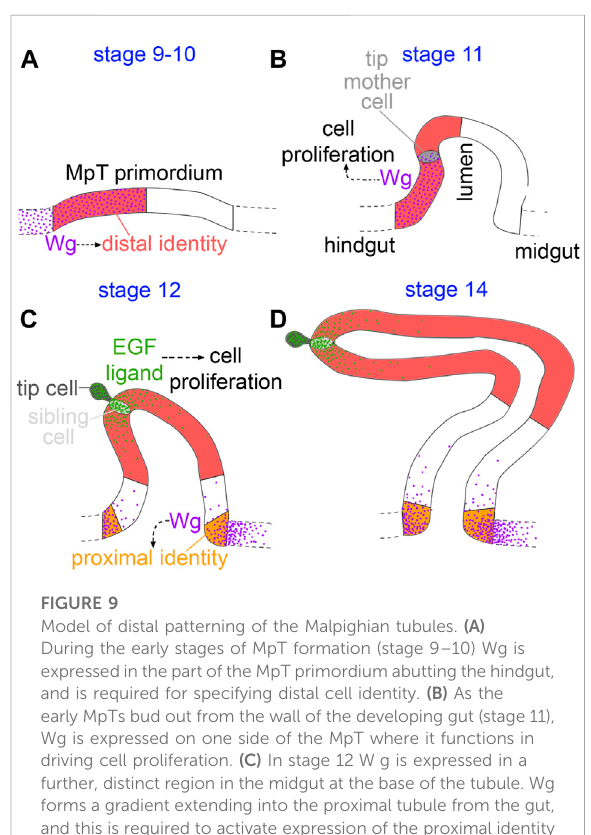
FIGURE 9 Model of distal patterning of the Malpighian tubules. (A) During the early stages of MpT formation (stage 9 – 10) Wg is expressedin the part of the MpT primordium abutting the hindgut, and is required for specifying distal cell identity. (B) As the early MpTs bud out from the wall of the developing gut (stage 11), Wg is expressed on one side of the MpT where it functions in driving cell proliferation. (C) In stage 12 W g is expressed in a further, distinct region in the midgut at the base of the tubule. Wg forms a gradient extending into the proximal tubule from the gut, and this is required to activate expression of the proximal identity factor Odd skipped (orange). During this stage the newly formed tip/sibling-cells produce the EGF ligand, spitz, which drives cell proliferation in a distal domain. This enlarges the distal cell population (D) , and is therefore necessary for the distal domain to reach its correct fi nal